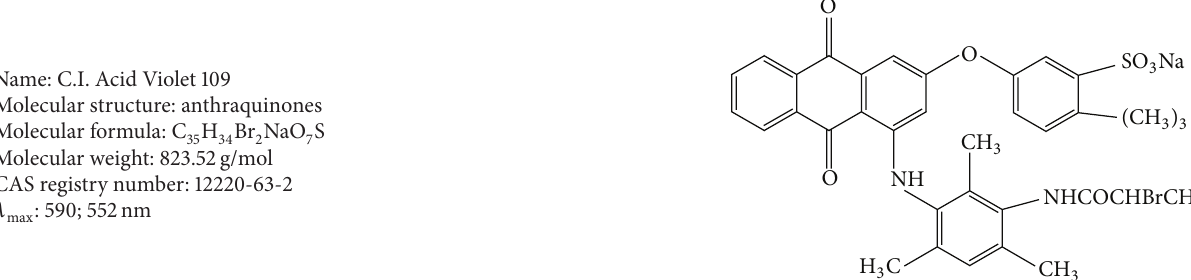
Molecular structure: anthraquinones